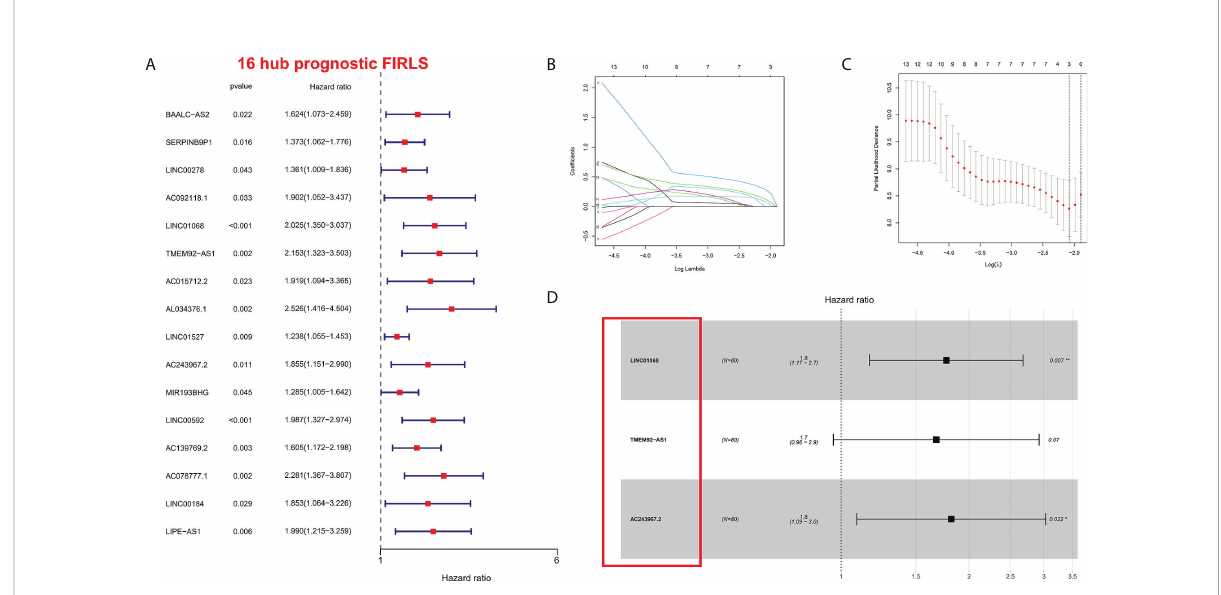
FIGURE 2 Construction of the risk strati fi cation system. (A) The FIRLs that signi fi cantly correlated with survival were identi fi ed by univariate analysis. (B, C) LASSO-validation. (D) Forest plot of hazard ratios showing the prognostic value of the 3 FIRLs. * P <0.05, ** P